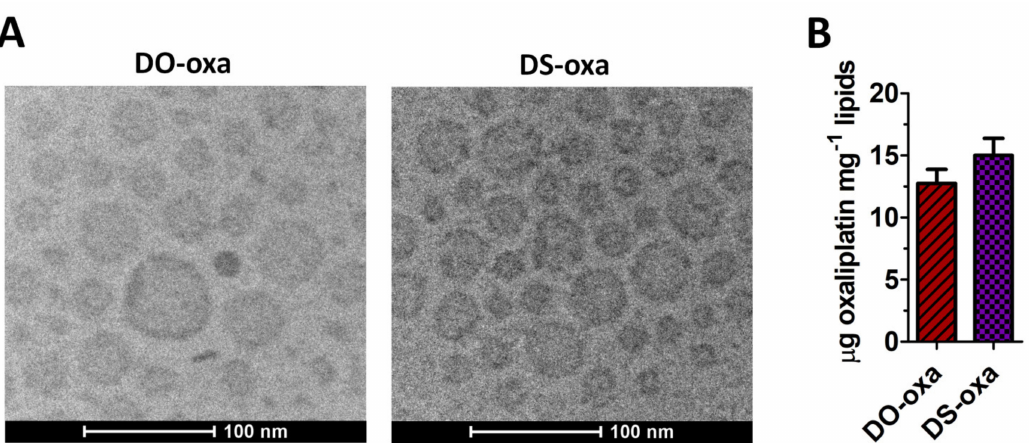
Figure 2. Oxaliplatin-loaded liposomes. ( A ) Cryo-transmission electron microscopy (cryo-TEM) micrographs of oxa-loaded liposomes. The cryo-TEM micrographs are representative of three independent experiments; ( B ) encapsulation e ffi ciency of oxaliplatin inside liposomes. The amount of oxaliplatin loaded inside liposomes was measured by HPLC connected with a diode array detector. The entrapment e ffi ciency was reported as µ g of drug per mg − 1 lipids. Oxa absorbance was measured at 249 nm. Error bars represent standard deviations. Statistical significance was calculated by one-way two-tailed t